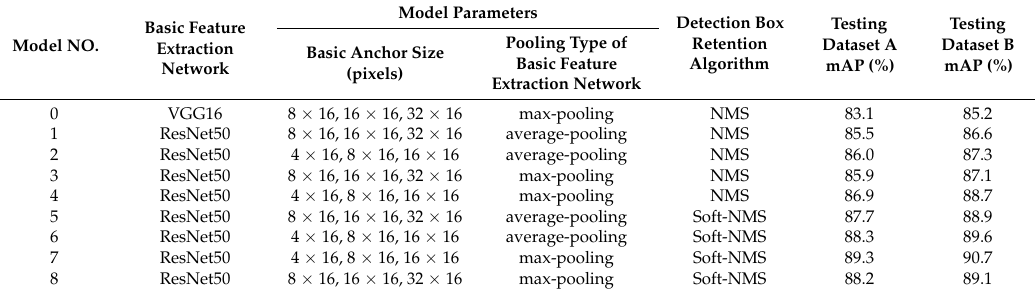
Table 1. Model parameter settings and mean average precision